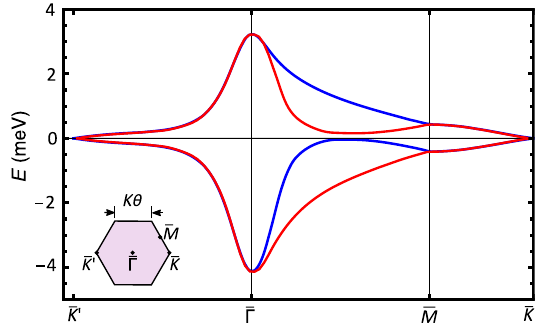
FIG. 3. Energy dispersion for MA TBG along high-symmetry lines in the moir´e Brillouin zone (BZ) for the continuum model dispersion [15] that is accurately described by the tight-binding model of Koshino et al. [17]. The bands shown in red and blue correspond to the two valleys of the original BZ and are related by time reversal.